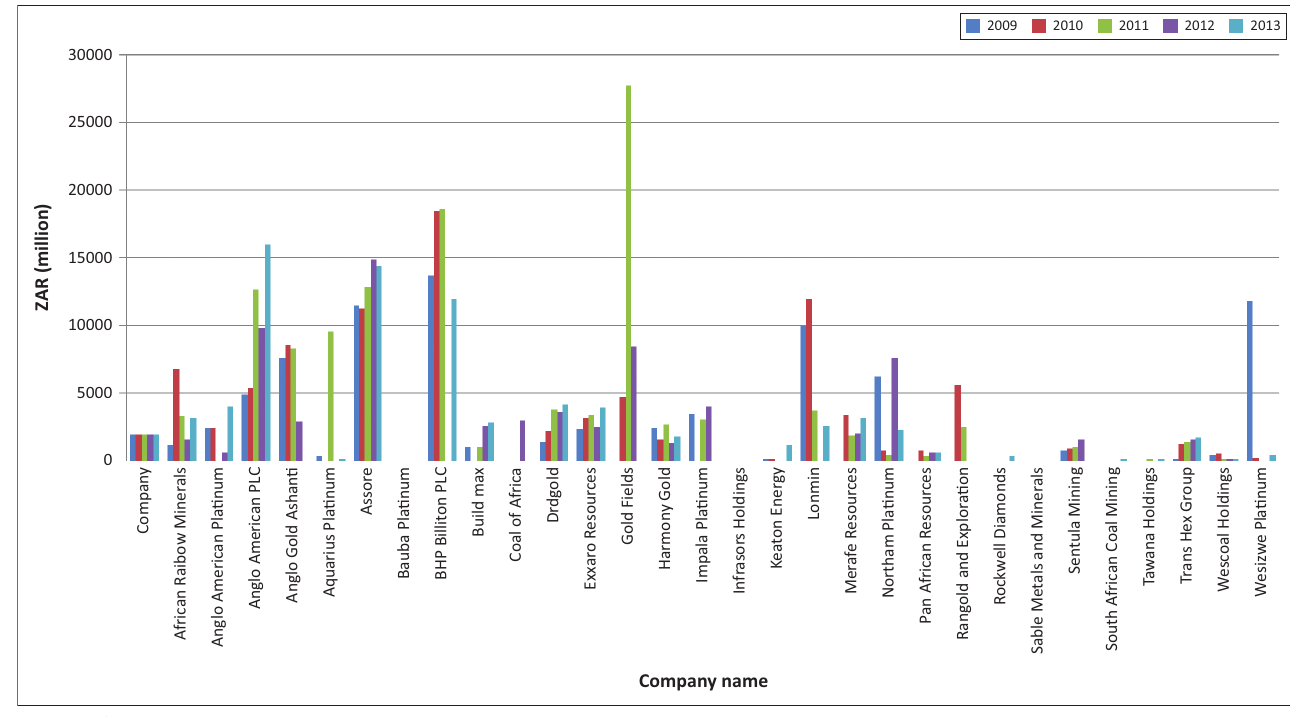
FIGURE 3: Short-term incentive pay component of chief executive officer mean average rate of 4.4 % , from ZAR 5 049 000 to ZAR 5 953 000 during the period of analysis. This translates to a compound increase of 4.2 % per year over the same period. The increase in the fixed component of executive pay between 2009 and 2010 was the highest within the study period at a mean average of 12.3 % . The increase in subsequent years was miniscule, while a negative growth was experienced in 2013 against an average inflation rate of 8.62 % over the study period. The rate of increase in the mean and median remains constant throughout the period of analysis.